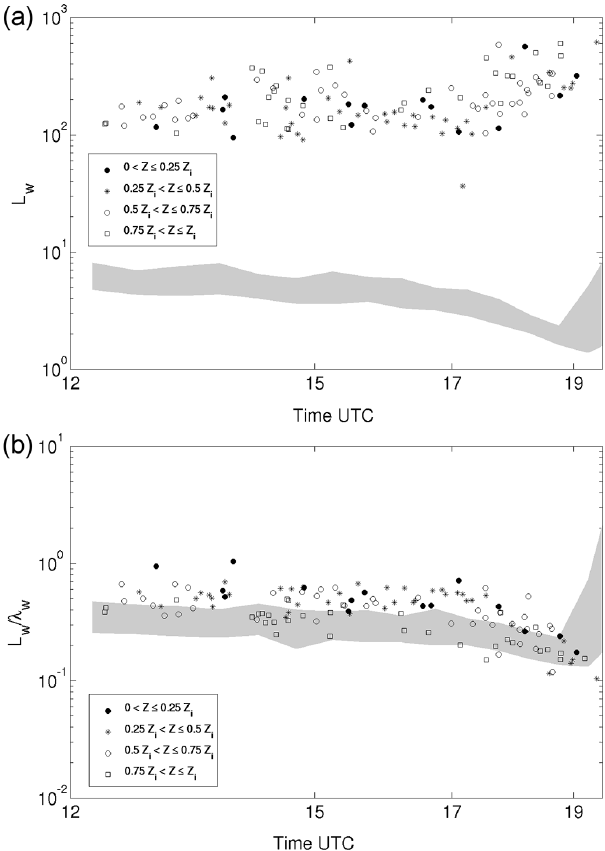
Figure 12. (a) Evolution of TKE decay observed during all IOP Figure 13. Time evolution of (a) the vertical wind integral scales days (shaded area) over five different surfaces and (symbols) from and (b) the ratio of the integral scales to the wavelength of maxi- the legs flown by the Piper Aztec and Sky Arrow aircraft. Note that mum spectral energy during all IOP days. The shaded area repre- a logarithmic scale is used on both axes. The shaded area represents sents the quartiles from 25 to 75% of ground-level estimates over the quartiles from 25 to 75% of surface estimates. The symbols four different surfaces and the symbols are used for legs flown at for the airplane legs differ according to altitude (see inserted leg- various heights by the Piper Aztec aircraft (see inserted end). (b) Evolution of reduced TKE over the afternoon for all IOP days over five different surfaces. Like in (a) , the shaded area repre- sents the quartiles from 25 to 75% of surface estimates. The dark grey shaded area corresponds to TKE/ w ∗ , and the light grey shaded area corresponds to TKE/ w ∗ , where w ∗ , is the convective velocity 0 0 scale at the time of maximum buoyancy flux.